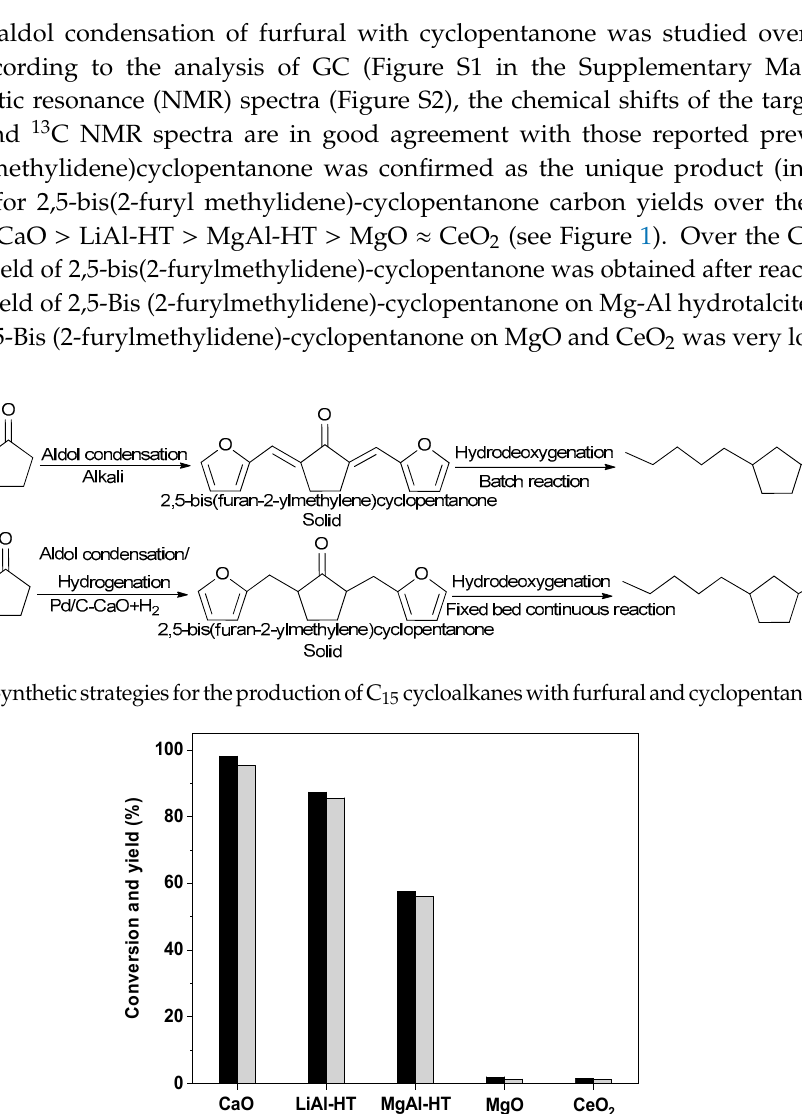
Figure 1. Cyclopentanone conversion (black columns) and carbon yield (gray columns) of 2,5-bis(2- furylmethylidene)-cyclopentanone on various solid base catalysts. Experimental conditions: 10 h, 423 K, and 0.84 g cyclopentanone (10 mmol), 1.92 g furfural (20 mmol), and 0.05 g catalyst were used in the tests.